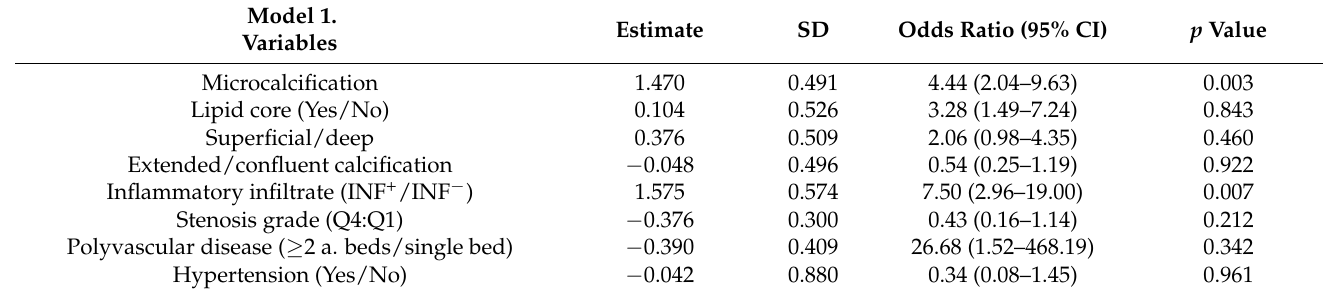
Table 4. Summary of multiple logistic regression analysis of the factors correlated to atheromatous plaque ulceration in the overall patient group ( n =